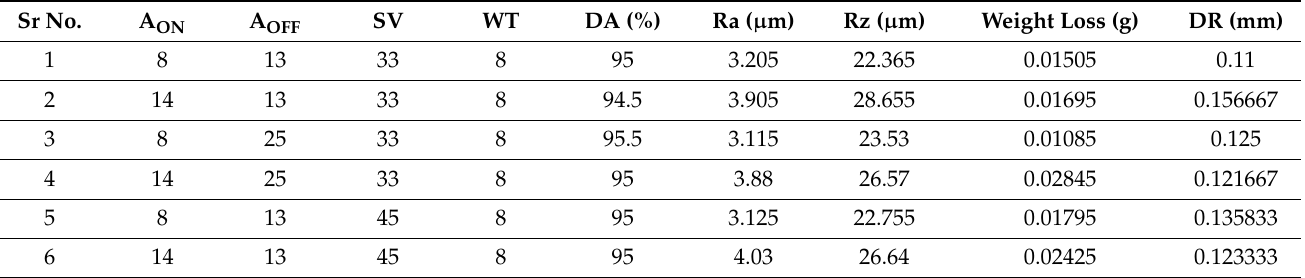
Table 4. Design matrix and corresponding